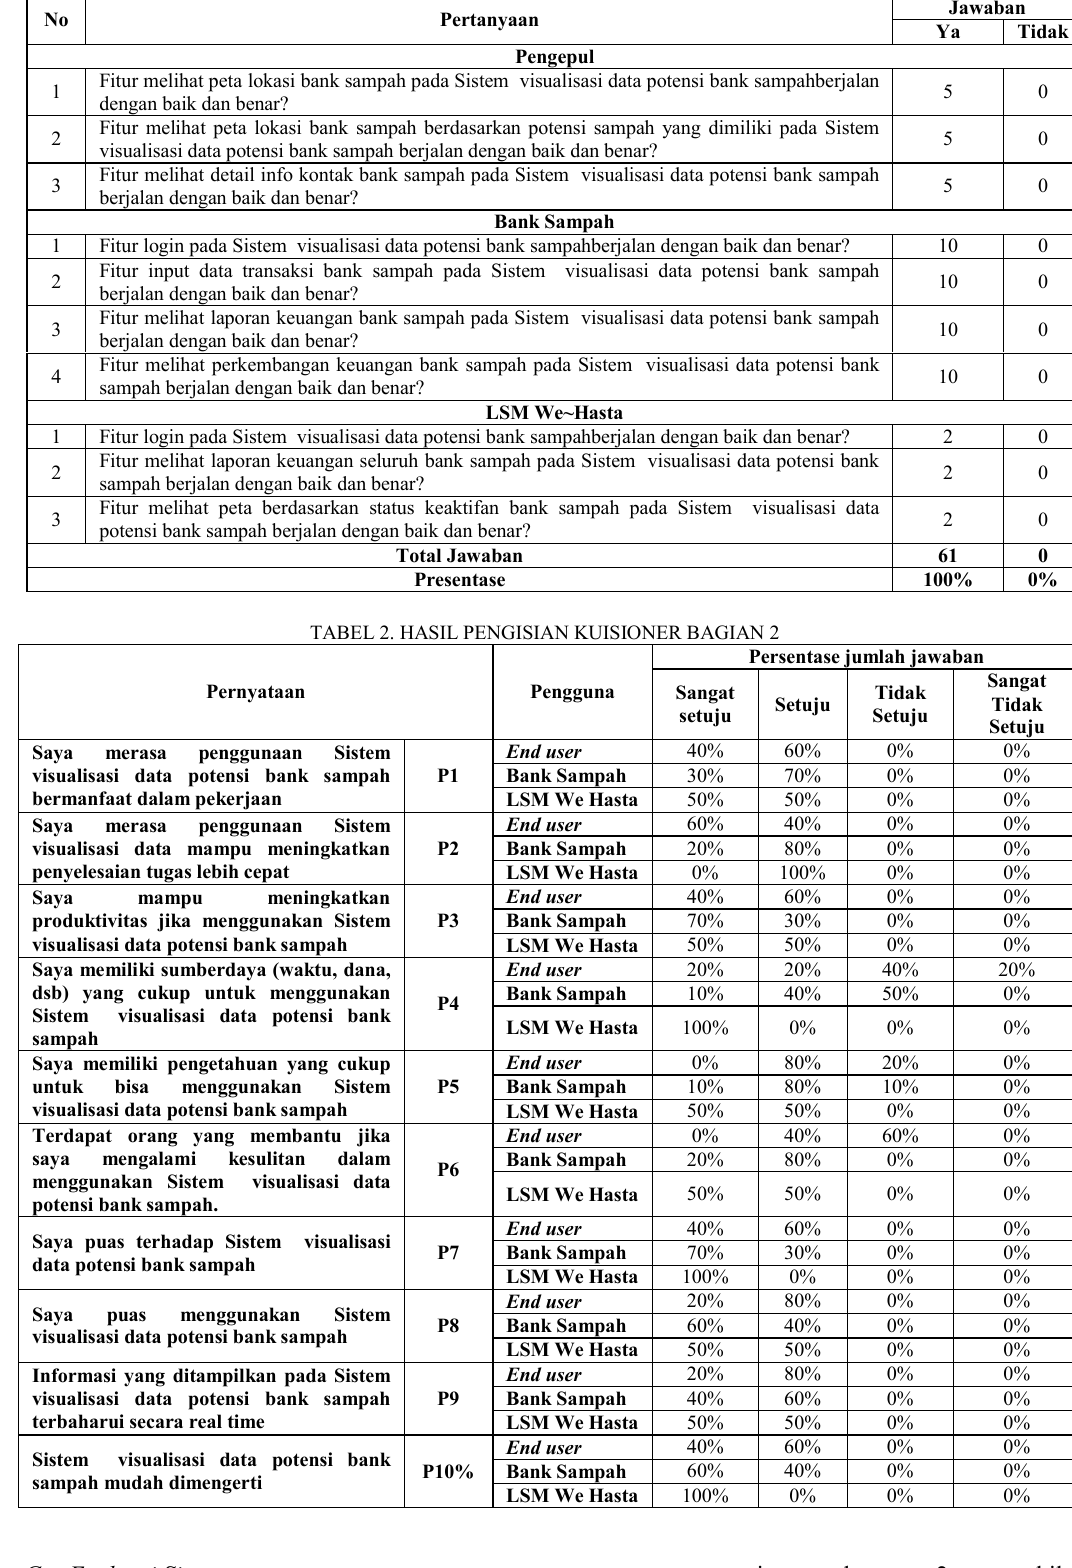
TABEL 1. HASIL PENGISIAN KUISIONER BAGIAN 1